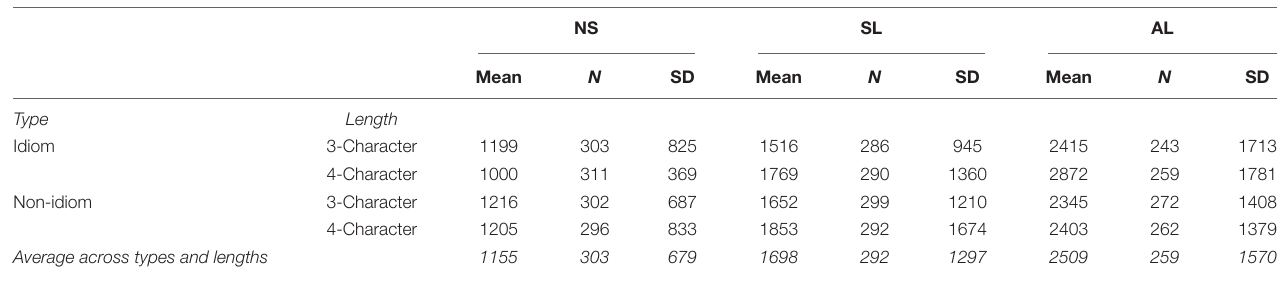
TABLE 4 | Raw RT (ms) by group, type of FSs, and length of